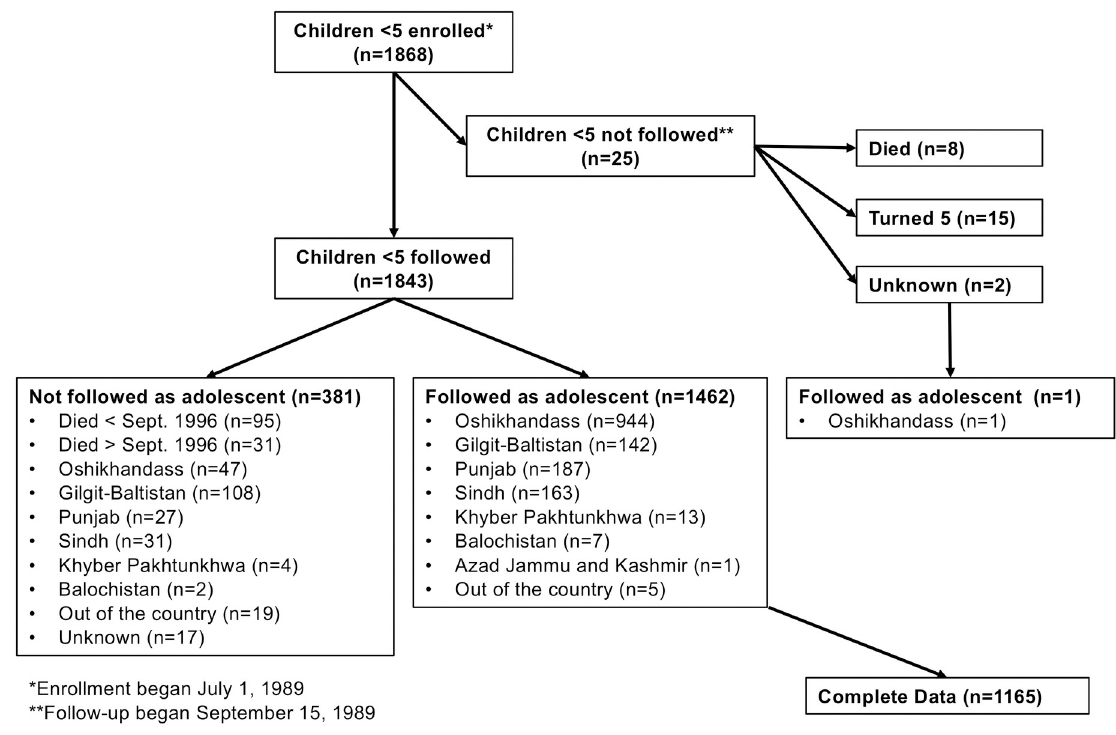
Fig 1. Flowchart of participant